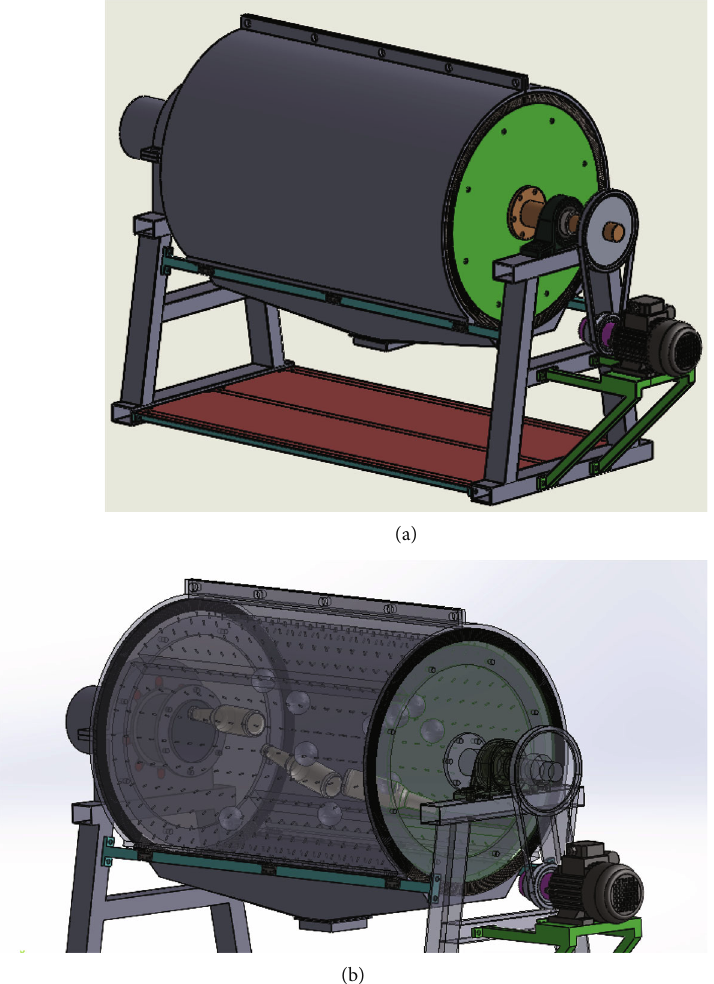
Figure 15: Isometric view of the